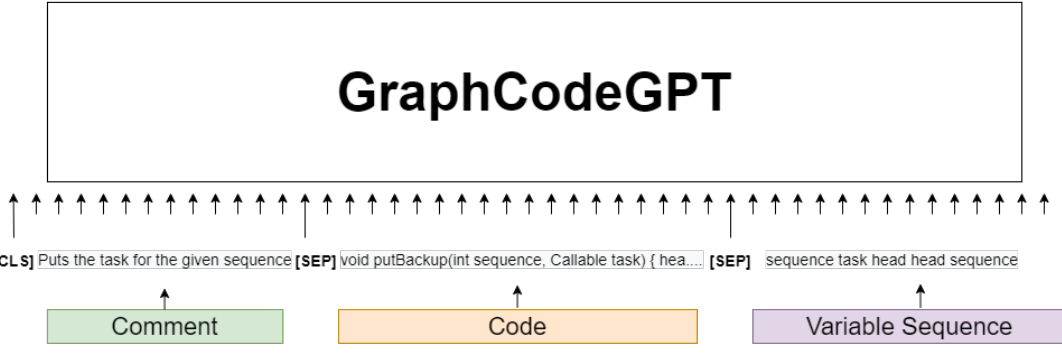
Figure 5. GraphCodeGPT pre-training architecture.